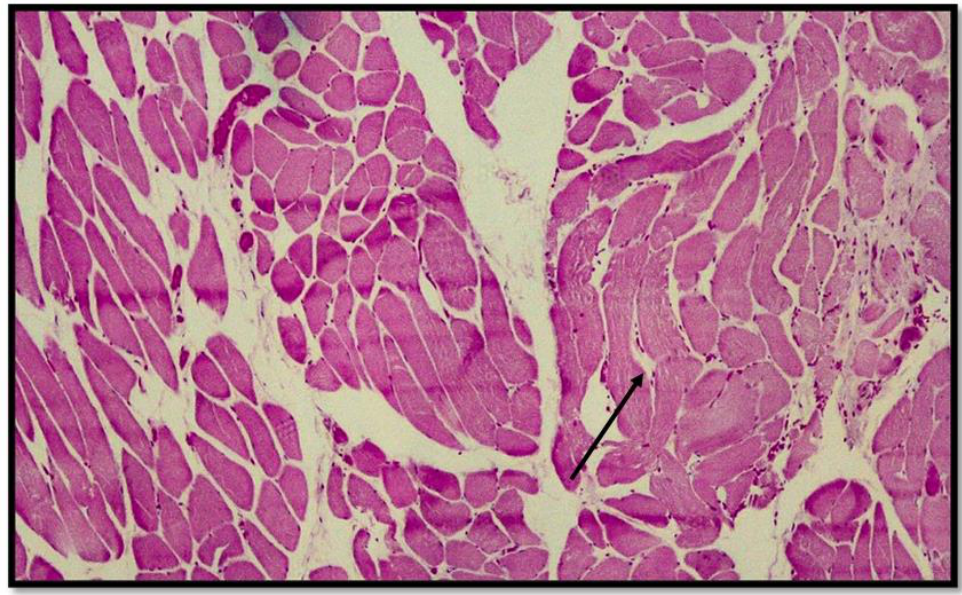
Figure 5. Photomicrograph showing more detailed striated muscle fiber cells with interspersed red blood cell extravasations (black arrow) (hematoxylin – Eosin, Diapath S.p.A.). Original magnification, 10×.